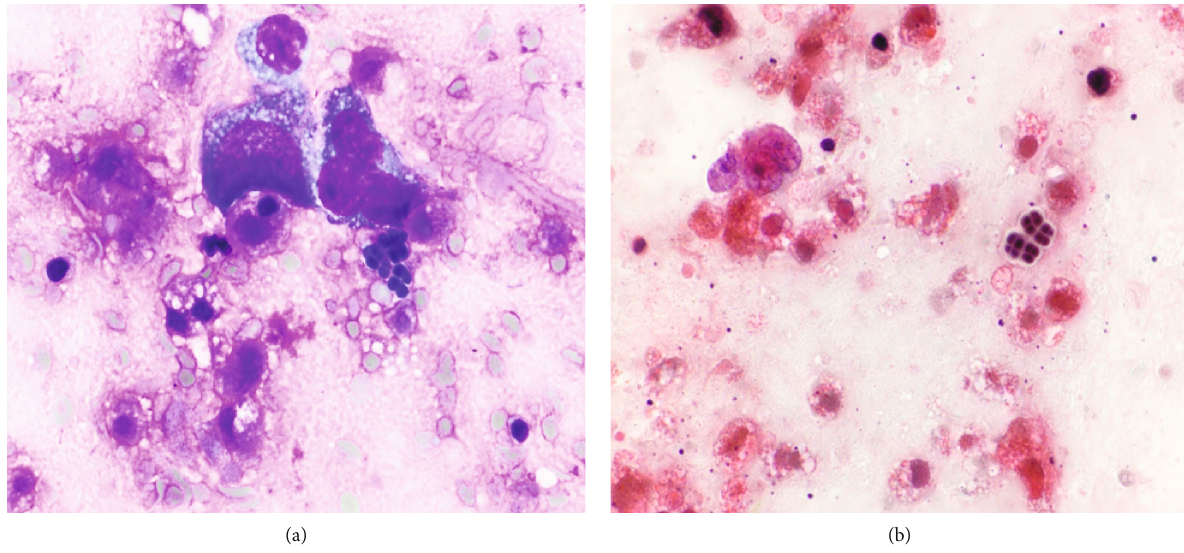
Figure 2: (a) As the diagnosis of malignancy was con fi rmed, scattered groups of microorganisms (arrows) were also identi fi ed in close proximity to some of the neoplastic cells (modi fi ed Giemsa stain, 1000X). (b) These clustered microorganisms were large and noted in tetrad arrangements with amphophilic tinctorial appearances (Papanicolaou stain,